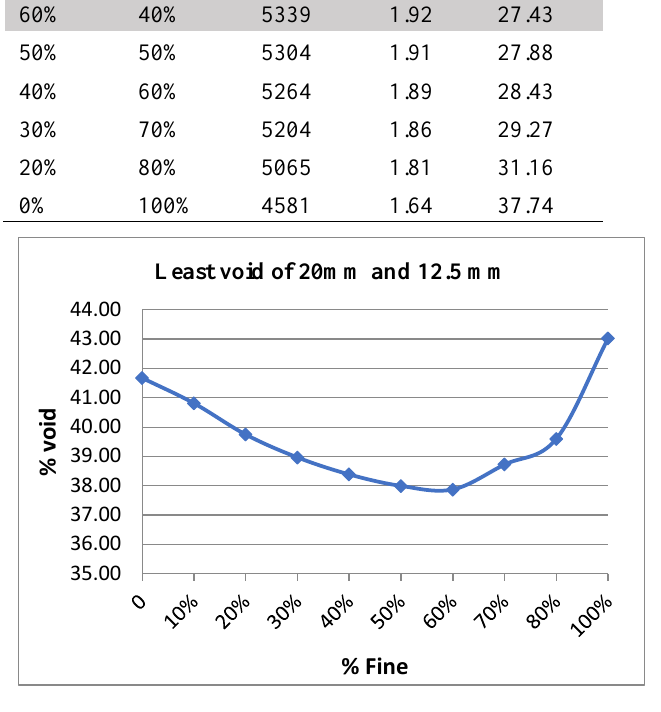
Fig. 5. Graph for Least void Proportion